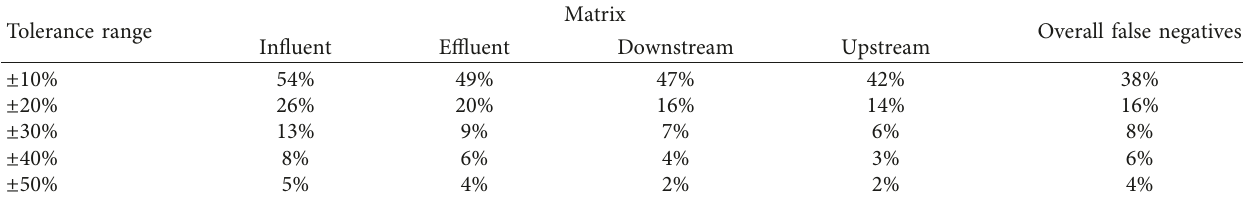
Table 3: Percent false negatives in spiked environmental matrices at different tolerance ranges for 23 compounds without tetracyclines and quinolones. Tolerance range